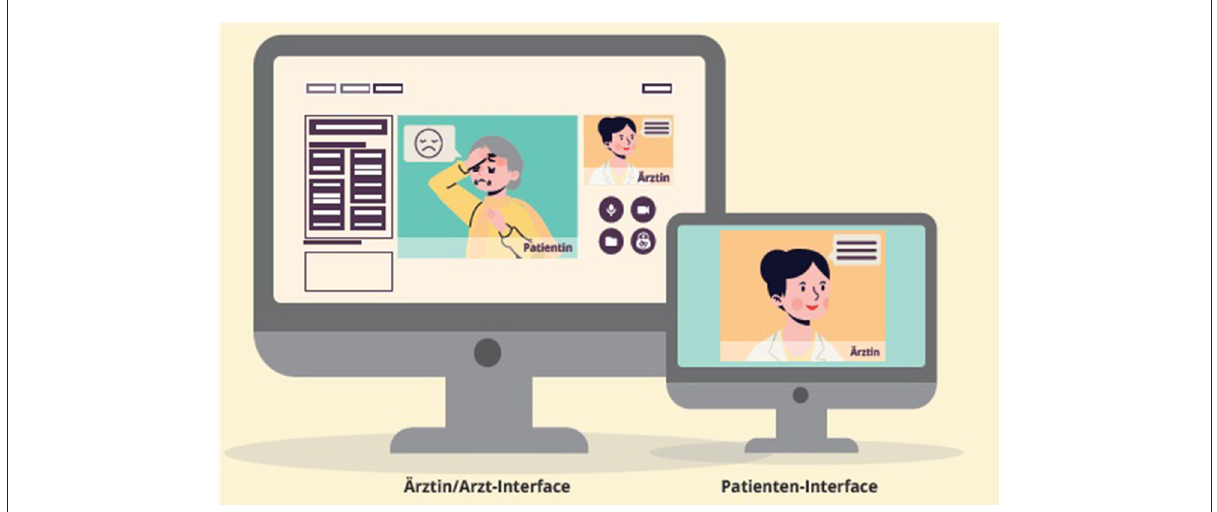
FIGURE1 Interface for the remote cognitive testing. The patient’s screen will typically show examiner ( = “Ärztin”) or test material (e.g., objects in a naming task). The examiner sees the patient ( = “Patientin”), a duplication of the patient’s screen (upper right) and tool lists to conduct and record the